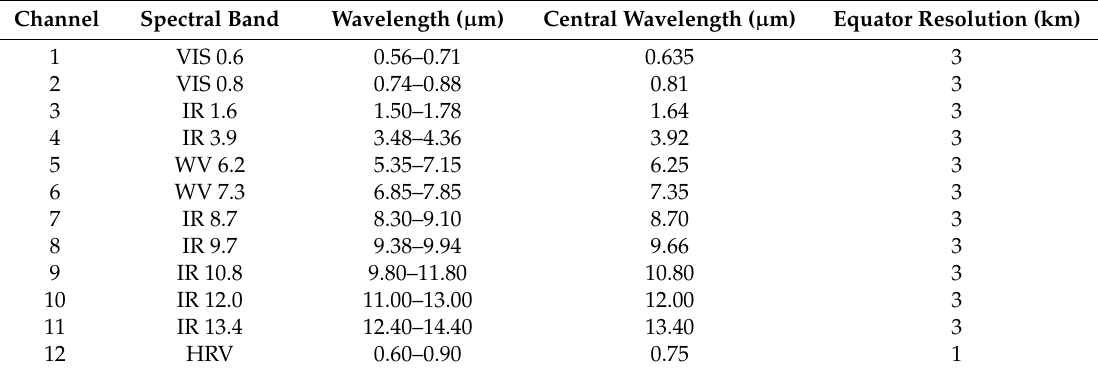
Table 1. Bands of SEVIRI radiometer